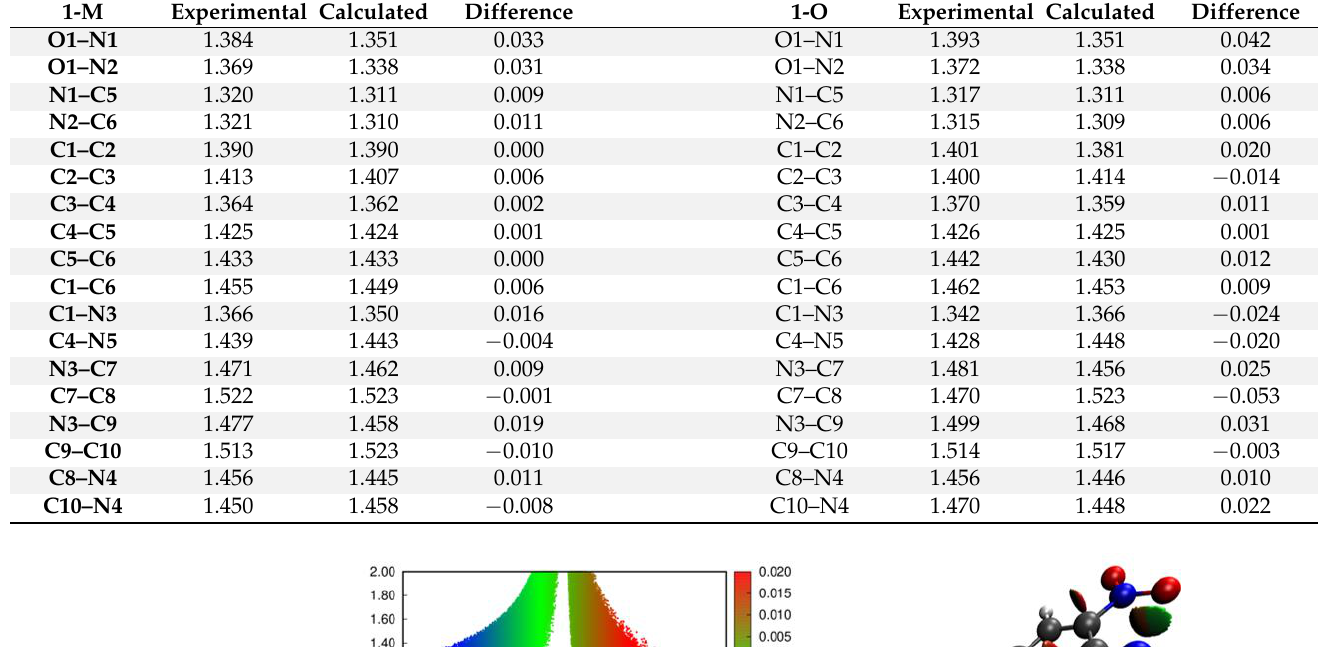
Table 1. Table listing experimental and calculated bond distances for both 1-M and 1-O . The difference (experimental–calculated) is also shown. All units are in Å.